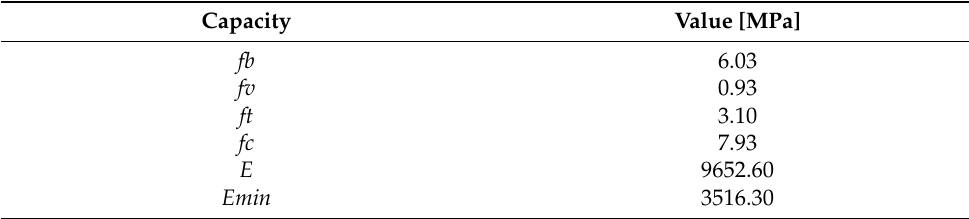
Table A4. Unfactored capacities for No. 1/2 Spruce Pine Fir